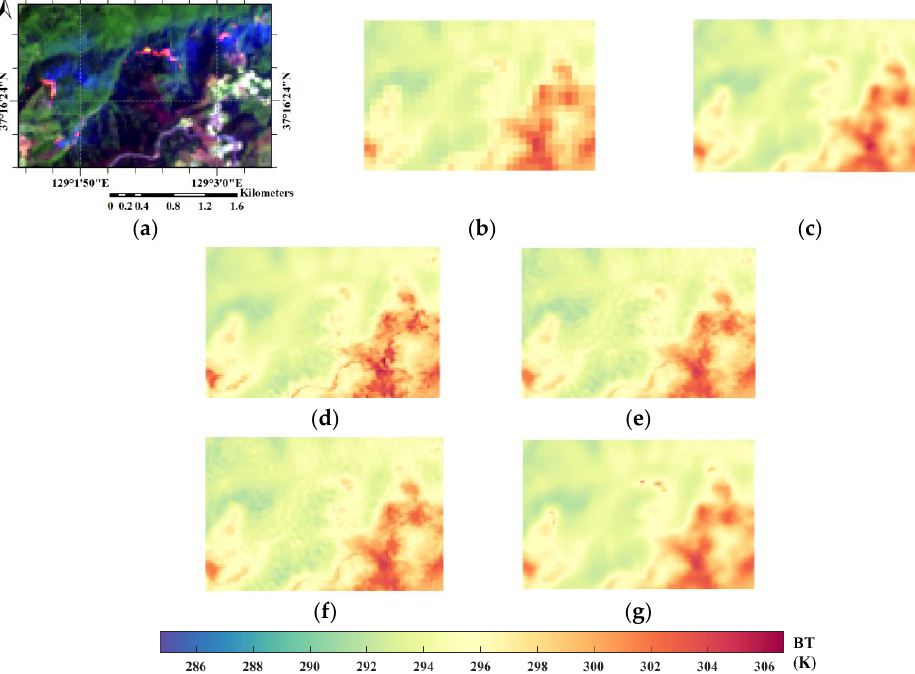
Figure 7. Disaggregated brightness temperature results at subset B: ( a ) SWIR2-SWIR1-Blue composite image; ( b ) Original BT image; ( c ) Distributed BT image; ( d ) DisTrad method; ( e ) TsHARP method; ( f ) LMS method; ( g ) Proposed GF method.